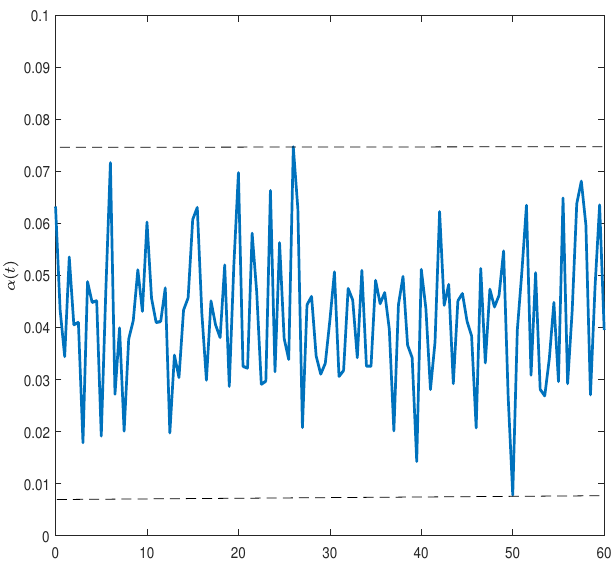
Figure 6. Optimal attention α ( t ) as a function of t .